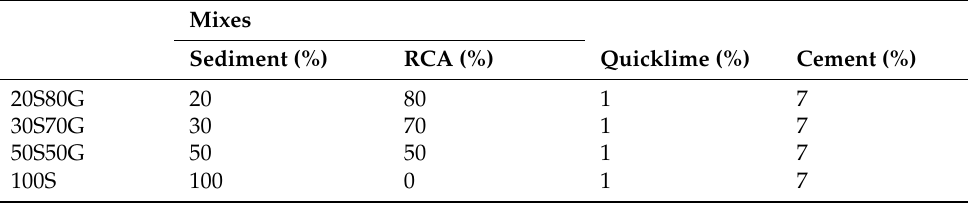
Table 5. Designed materials for recycling sediments and granular